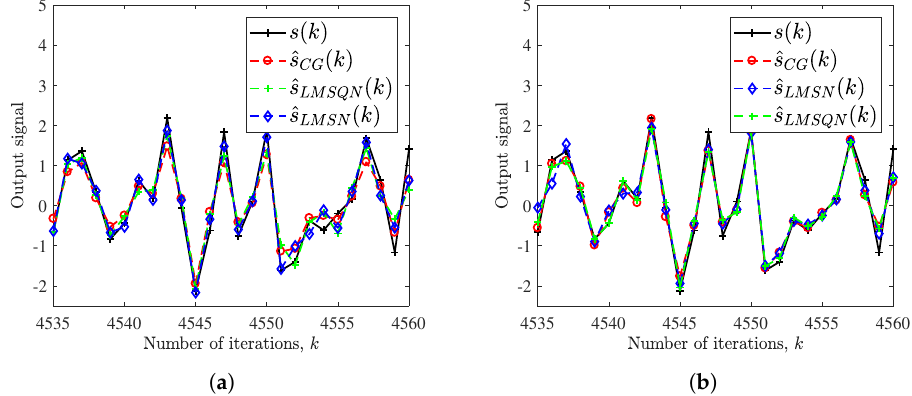
Figure 3. Simulation 1: Comparison between the transmitted and the recovered signal by the DS-CG, DS-LMSQN and DS-LMSN algorithms for ( a ) P up = 0.45 and ( b ) P up =